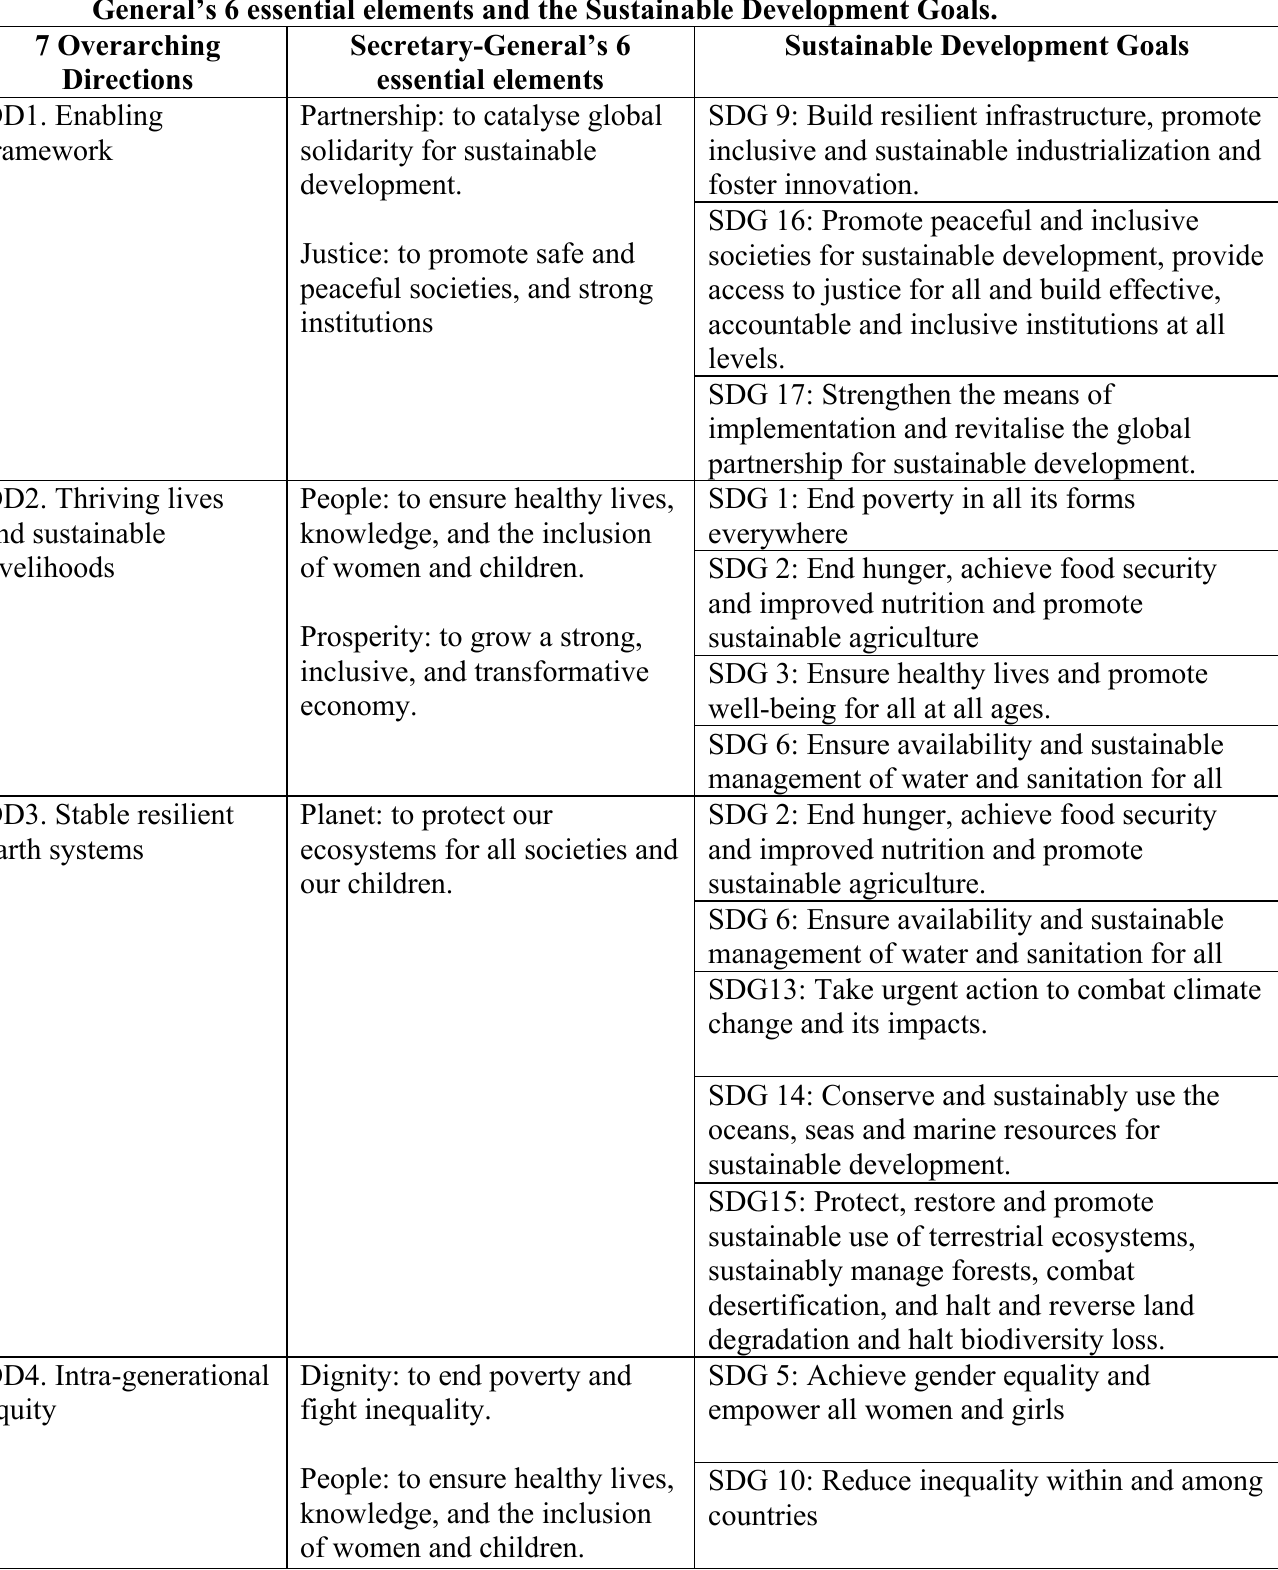
Table A1. Comparison of the 7 Overarching Directions (ODs), the Secretary- General’s 6 essential elements and the Sustainable Development